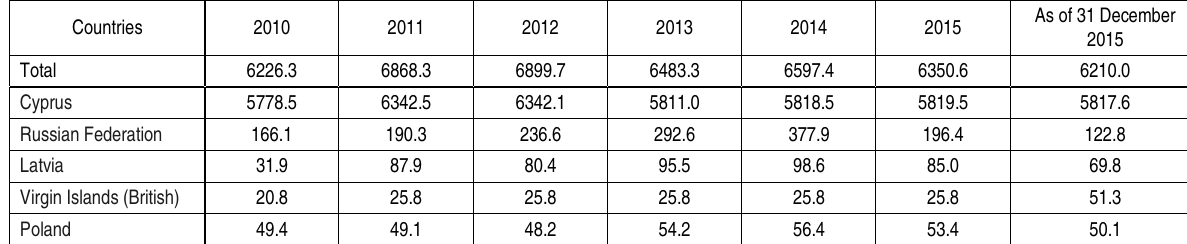
Table 3. Direct investments (joint-stock capital) to Ukraine from the world’s countries (volumes of direct investments as of January 1), million US